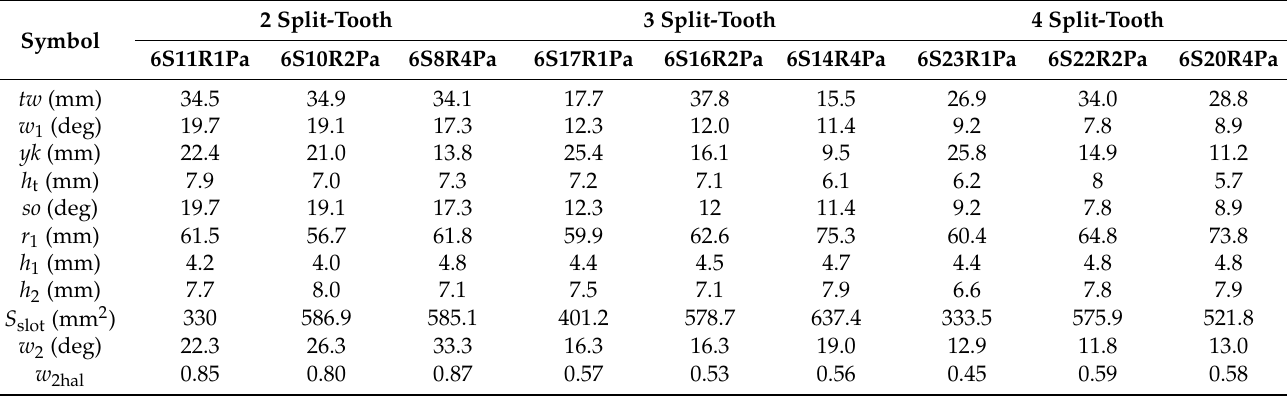
Table 2. Parameters of optimized 6-slot STDPM machines with a different split-tooth number and armature pole pair